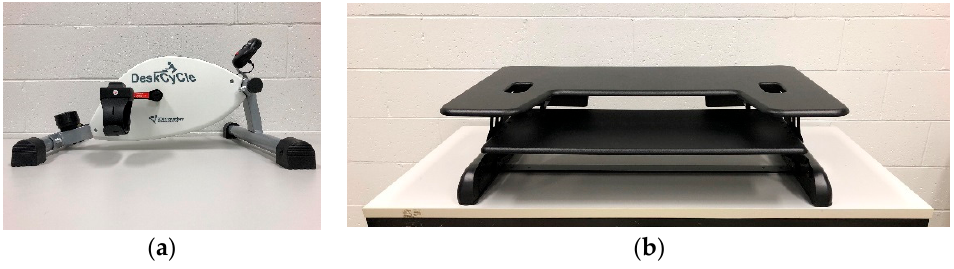
Figure 2. ( a ) Portable pedal exercise machine; ( b ) standing desk.